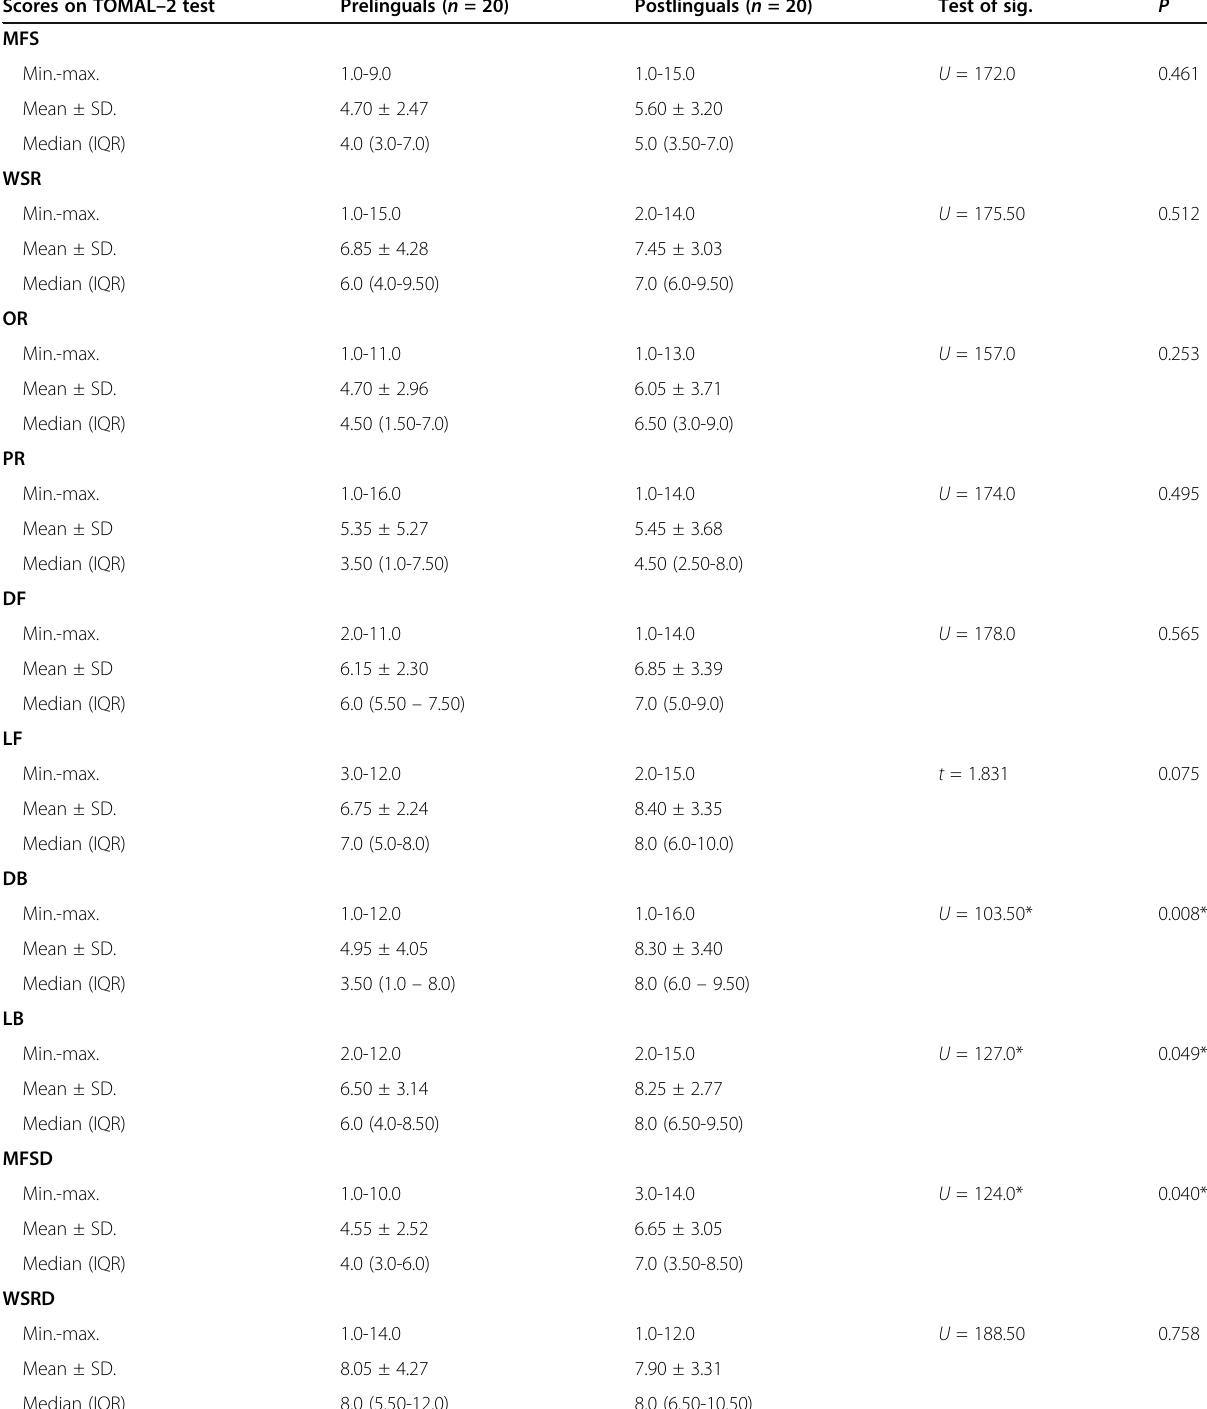
Table 5 Comparison between prelingual and postlingual according to scaled scores of TOMAL-2